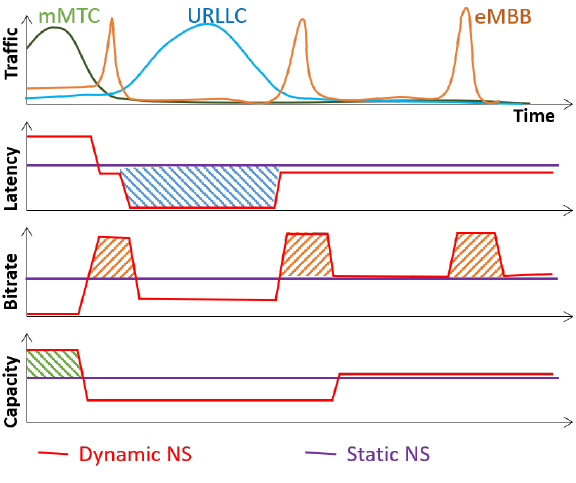
Figure 10. Expected